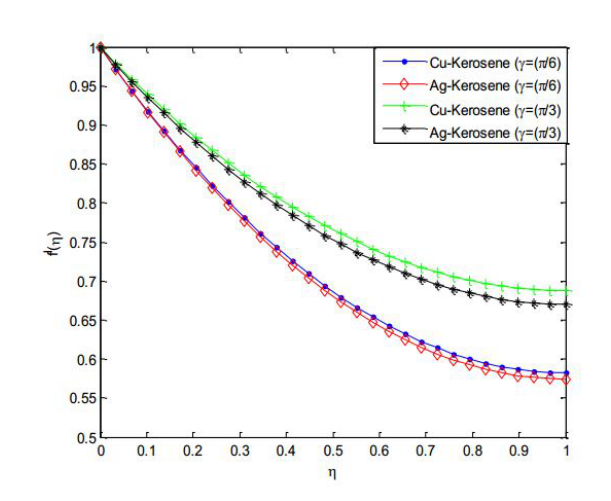
Figure 12. Effect of aligned angle on the fluid velocity